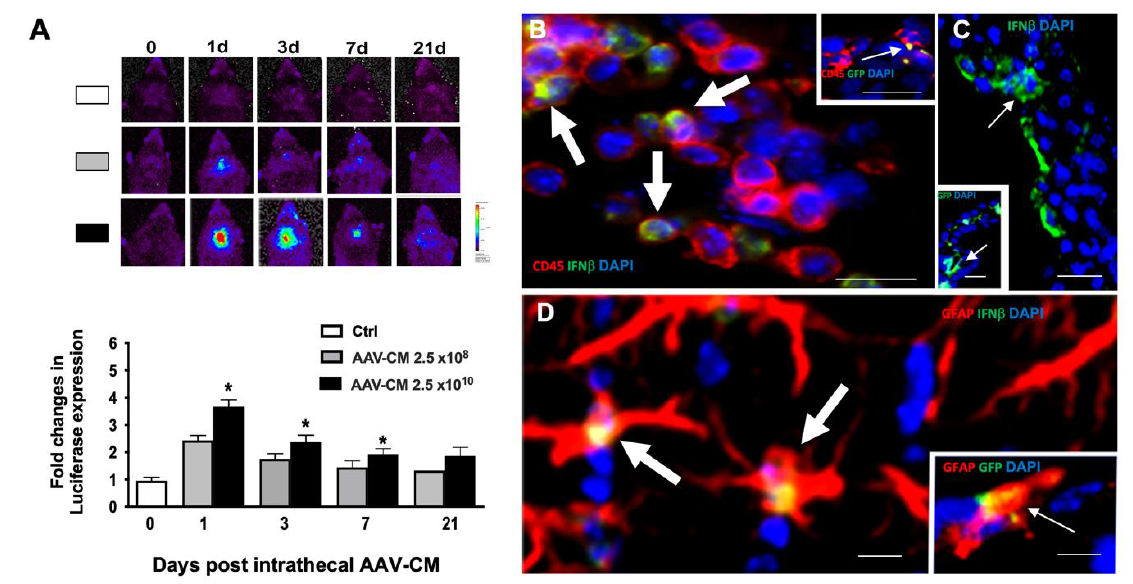
Figure 1. Intrathecal AAV-CM induces sustained IFN β . ( A ) IFN β expression in the brain was evaluated in luciferase reporter mice by in vivo imaging and showed that intrathecal administration of AAV-CM induced IFN β in the CNS of mice was dose-dependent. In vivo imaging of IFN β /luciferase reporter mice that received intrathecal AAV-CM. The level of IFN β was significantly increased at 1-, 3- and 7-days post injection and was detectable up to 21 days post injection. n = 3–4 in each group. B–D) Micrographs of brain sections from mice that received AAV-CM or AAV-GFP intrathecally. Nuclei were stained with DAPI (blue). ( B ) Co-localization (arrows) of IFNY β /YFP + (green) and extraparenchymal CD45 + cells (red) in mice are shown. Insert shows the co-localization of GFP+ (green) and extraparenchymal CD45 + cells. ( C ) IFNY β /YFP + (green, arrow) or GFP+ cells (green in insert, arrow) in the choroid plexus. ( D ) Co- localization (arrows) of IFNYβ/YFP+ (green) or GFP+ cells (green in insert) and GFAP+ (astrocytes) in the perivascular area of the lateral ventricle. Data are presented as mean ± SEM. The results were analyzed using the two-tailed Mann – Whitney u- test. * p < 0.05, Scale bars. 10 µm.